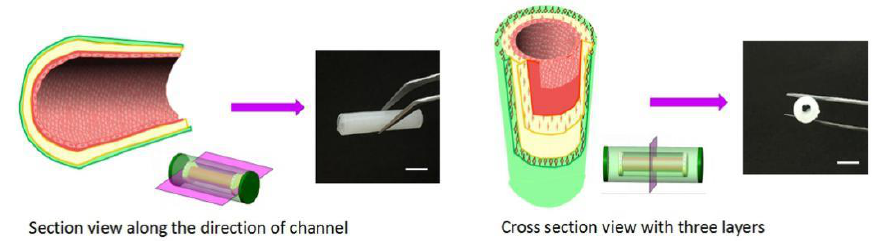
Figure 9. Mechanical properties of the supporting scaffold. ( a ) Varying ratios of SE1700 to the catalyst (For I~IV, the ratios were 10:1, 10:0.6, 10:0.5, and 10:0.3, respectively; their wall thicknesses were the same, i.e., approximately 250 μm. For V~VII, the wall thicknesses were different —250 μm, 200 μm, and 150 μm, respectively— and their ratios of SE1700 to the catalyst were the same —10:0.6 μm). (Scale bar: 5 mm). ( b ) Load and tensile displacement curves of the samples (I~VII). ( c ) Mean values for the static elastic modulus, with the number of measurements (specimens) shown in brackets [36].